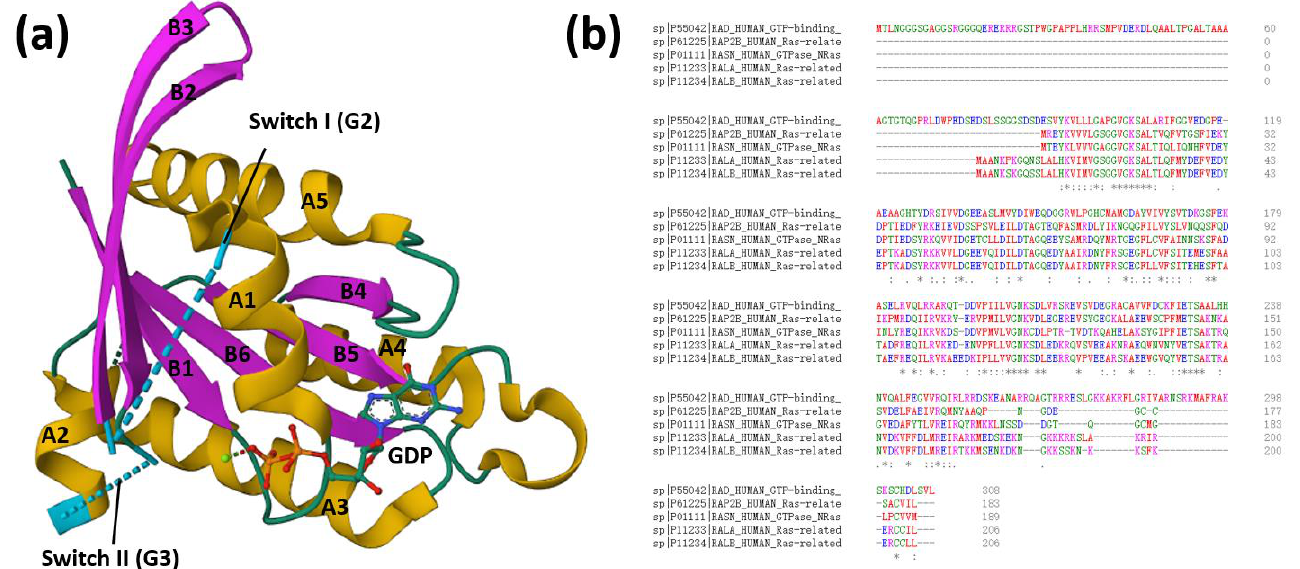
Figure 1. Structure of human RRAD. ( a ) The crystal structures of human RRAD. RRAD contains five α -helices (A1–A5) in yellow and one large β -sheet in pink (PDB ID: 2DPX, general view), that comprise two extended anti-parallel β -strands (B2 and B3) and five extended parallel β -strands (B3, B1, B4–B6). Both Switch I and Switch II of RRAD are disordered. The switch I region of RRAD lacks the G2 motif which is generally contained by small GTPases. This motif is important for nucleotide binding. Additionally, RRAD lacks the conserved phenylalanine (Phe28 of H-Ras) that traps the GDP molecule through non-polar interactions with the base and sugar. However, Arg109 on helix A1 serves to hold the nucleotide by forming a water-mediated hydrogen bonding network. The magnesium ion is combined with the side chain of Ser105. As Ser105 mutation can eliminate the binding of GTP, magnesium ion seems to be more critical to the binding of GDP and Rad than other GTP enzymes. The disordered switch II suggests conformational flexibility. The G3 motif comprises the N-terminal half of switch II. RRAD displays no significant changes in the overall fold compared to other Ras-family GTPases. ( b ) Sequence alignment of human RAD, RAP2B, RASN, RalA, and RalB.(https://www.ebi.ac.uk/Tools/services/web/toolresult.ebi?jobId=clustalo-I20230 227-084742-0410-26884510-p1m&showColors=true&tool=clustalo, accessed on 27 February 2023). (*) indicate strict identity between sequences; (:) indicate strong similarity; (.) indicate weak similarity and (-) represent alignment